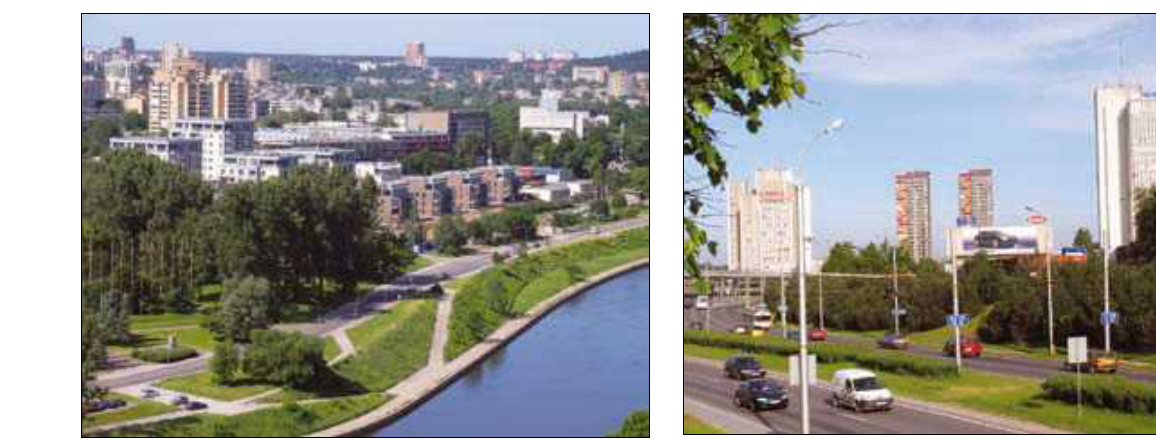
19 pav. Du­ au­kštybiniai dau­giabu­čiai pastatai Viršu­liškių skg. (archit. G. Čaikau­skas, M. Šejnicki) Fig. 19. two high-rise blocks of flats in Viršu­liškės a­lley. a­rch. G. Čaikau­skas, M.